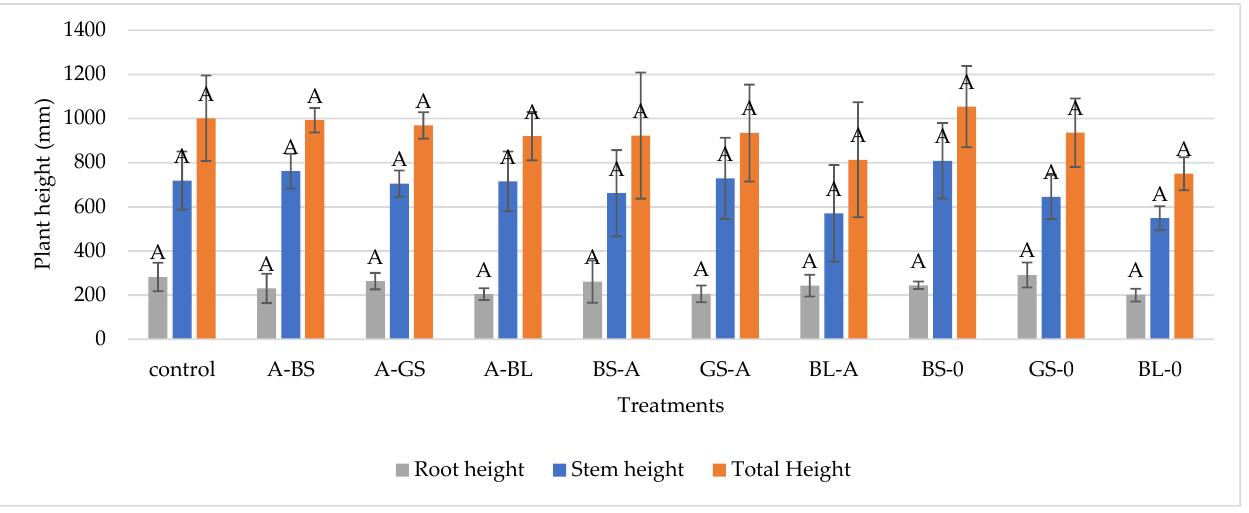
Figure 7. Effect of different treatments on plant heights comparing m ean significance with Tukey HSD . Capital letters indicate the statistically different results groups.